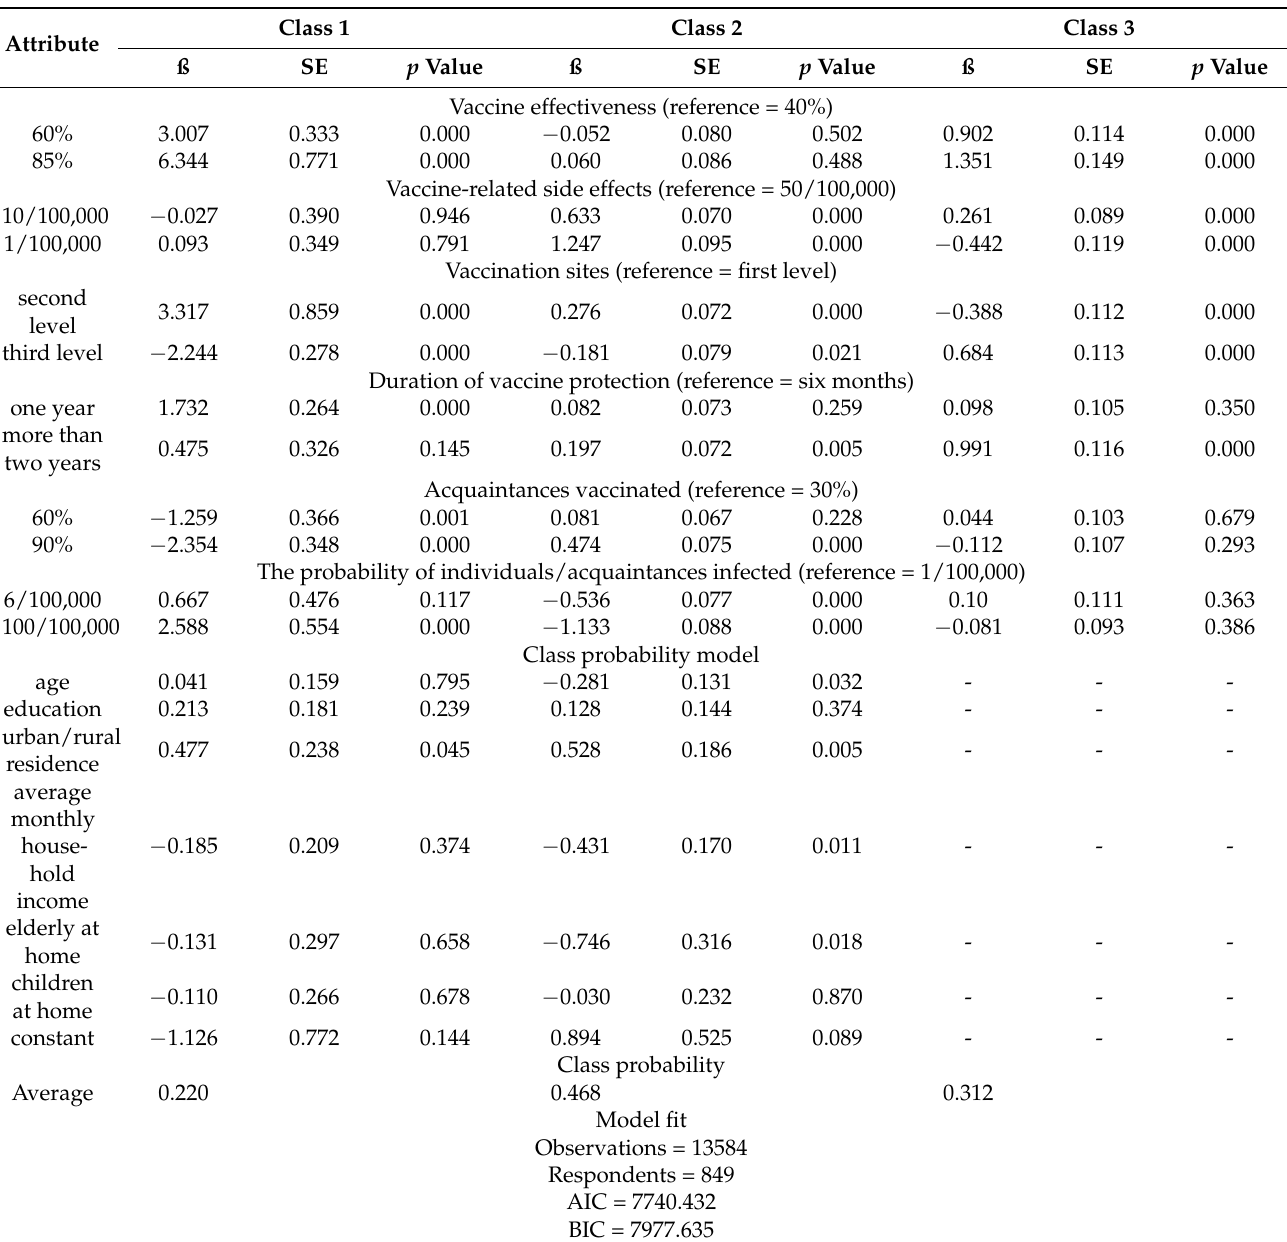
Table 6. Latent class logit model of patient